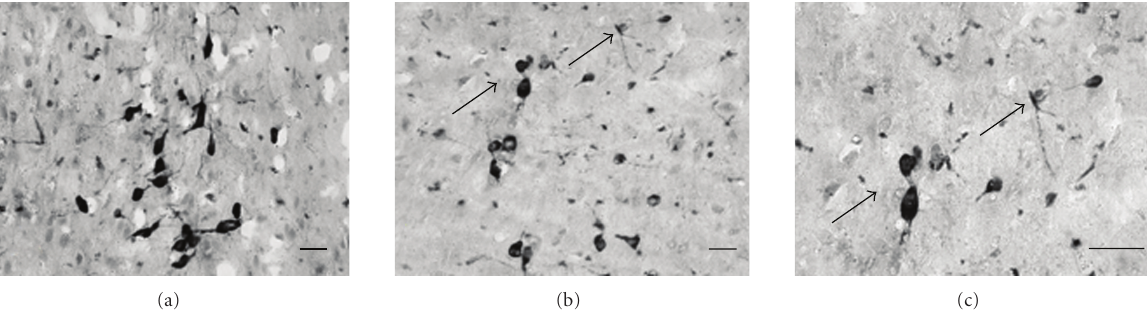
Figure 4: Pro-NGF treatment resulted in observable degeneration of the cholinergic neurons stained for Choline Acetyl Transferase (ChAT; (b), (c)) when compared to age matched saline animals (a). Arrows in (b) point to neurons represented in (c) under higher magnification. Scale bar = 50 μ m, 20x ((a) and (b)) and 40x